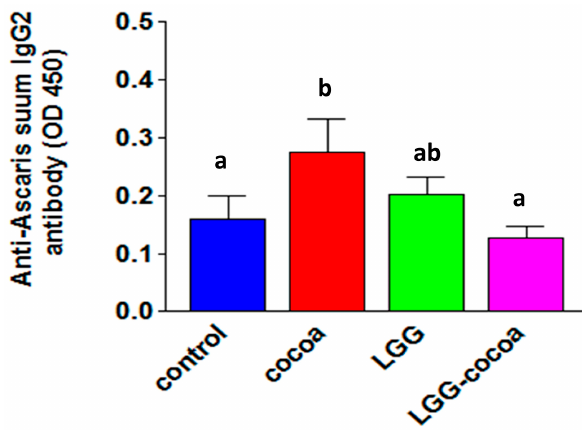
Figure 5. Anti- Ascaris IgG2 antibody response. The anti- Ascaris IgG2 antibody response was measured using A . suum proteins extracted from isolated third and fourth stage larvae and serum obtained 10 days post-inoculation with infective A . suum eggs. Bound serum antibody at a 1/1000 dilution was detected using biotinylated anti-pig IgG2 followed by streptavidin-HRP complex. Values shown are means ± SEM ( n = 8 per treatment). Labeled means without a common letter differ, p < 0.05.